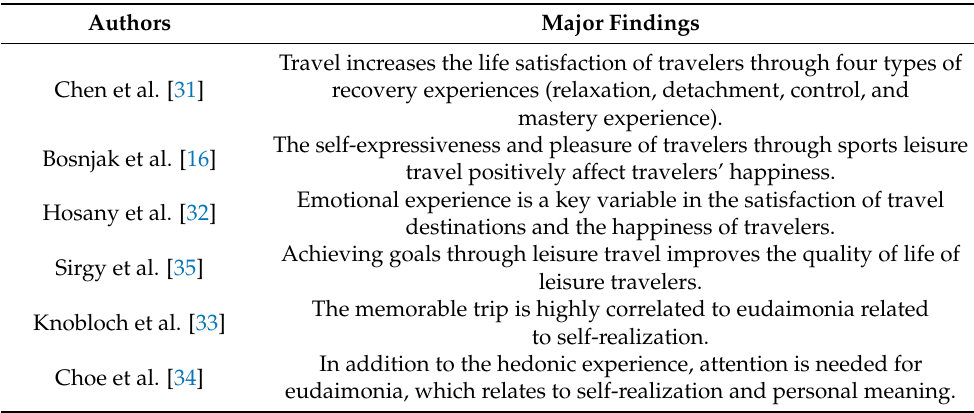
Table 1. Summary Review of Travel Experience and Travelers’ Happiness